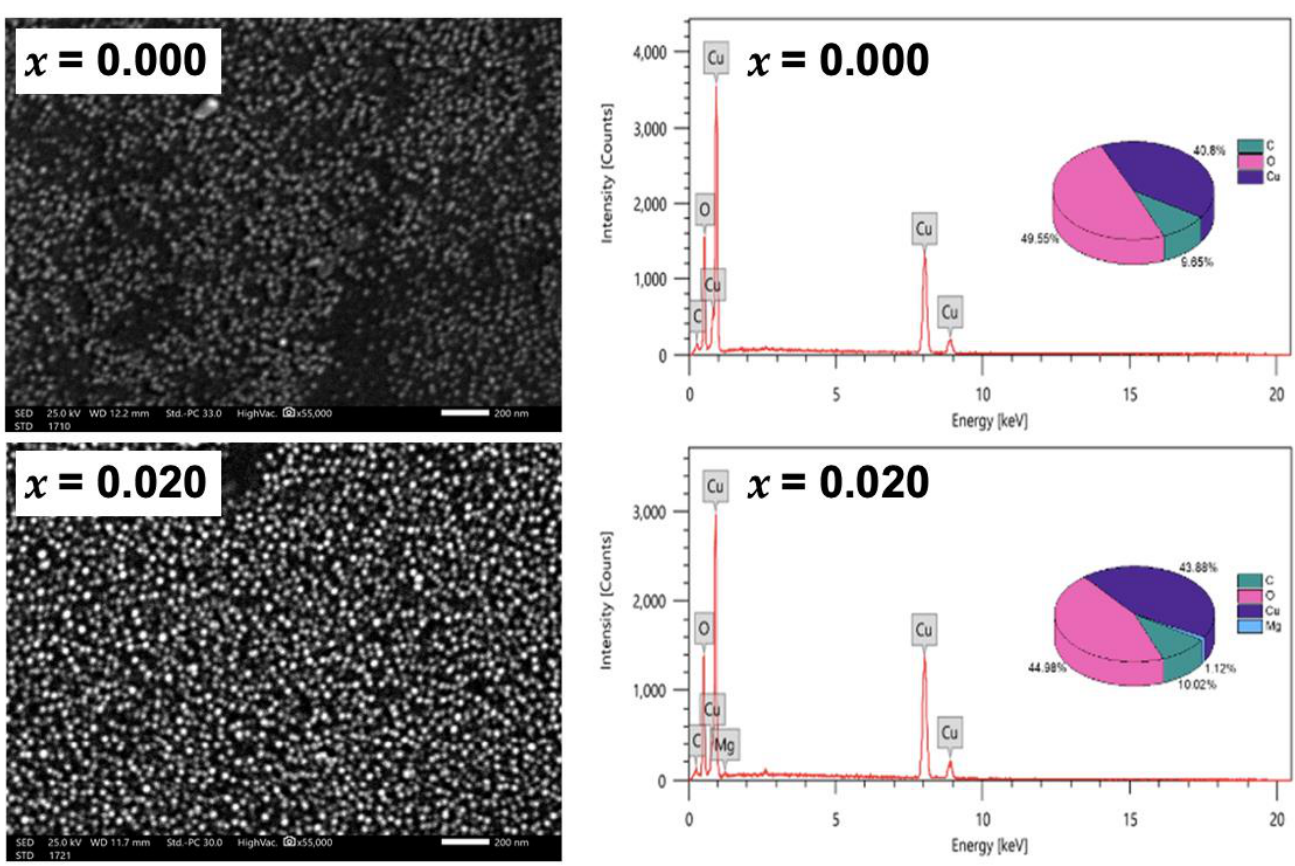
Figure 3. SEM and EDX patterns for undoped, and Mg-doped CuO NPs (Cu 1 −x Mg x O NPs).